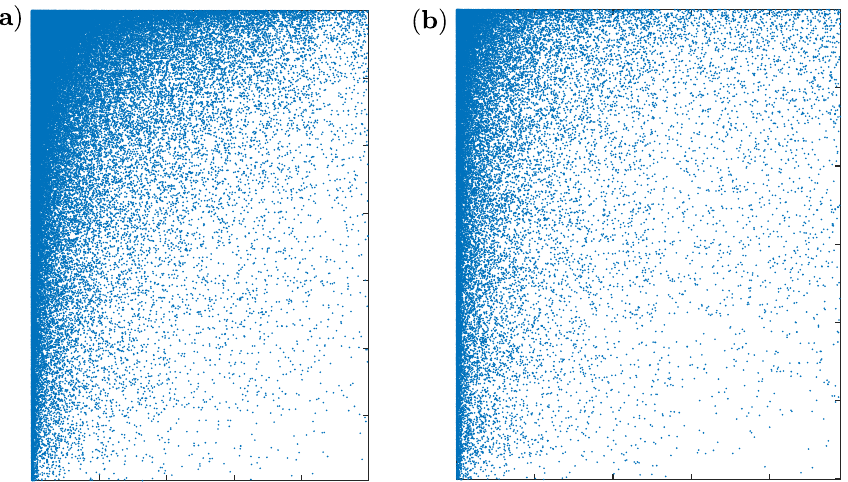
Figure 3. Evidence of nestedness in Stack Overflow’s user-tag bipartite networks. ( a ) User-tag bipartite network for answers posted in January 2009 (size: 6960 × 4982 ). ( b ) User-tag bipartite network for questions posted in January 2009 (size: 6011 × 4906 ). In both panels blue dots represent non-zero entries, and the matrix rows and columns have been sorted from top to bottom for users and from left to right for